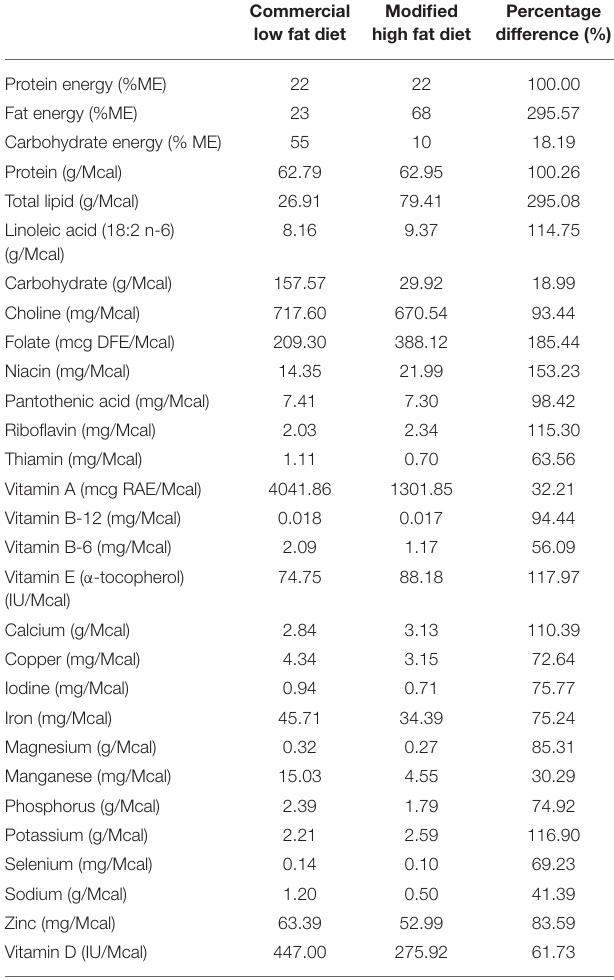
TABLE 1 | The nutrient profile of the low fat commercial diet and the modified high fat